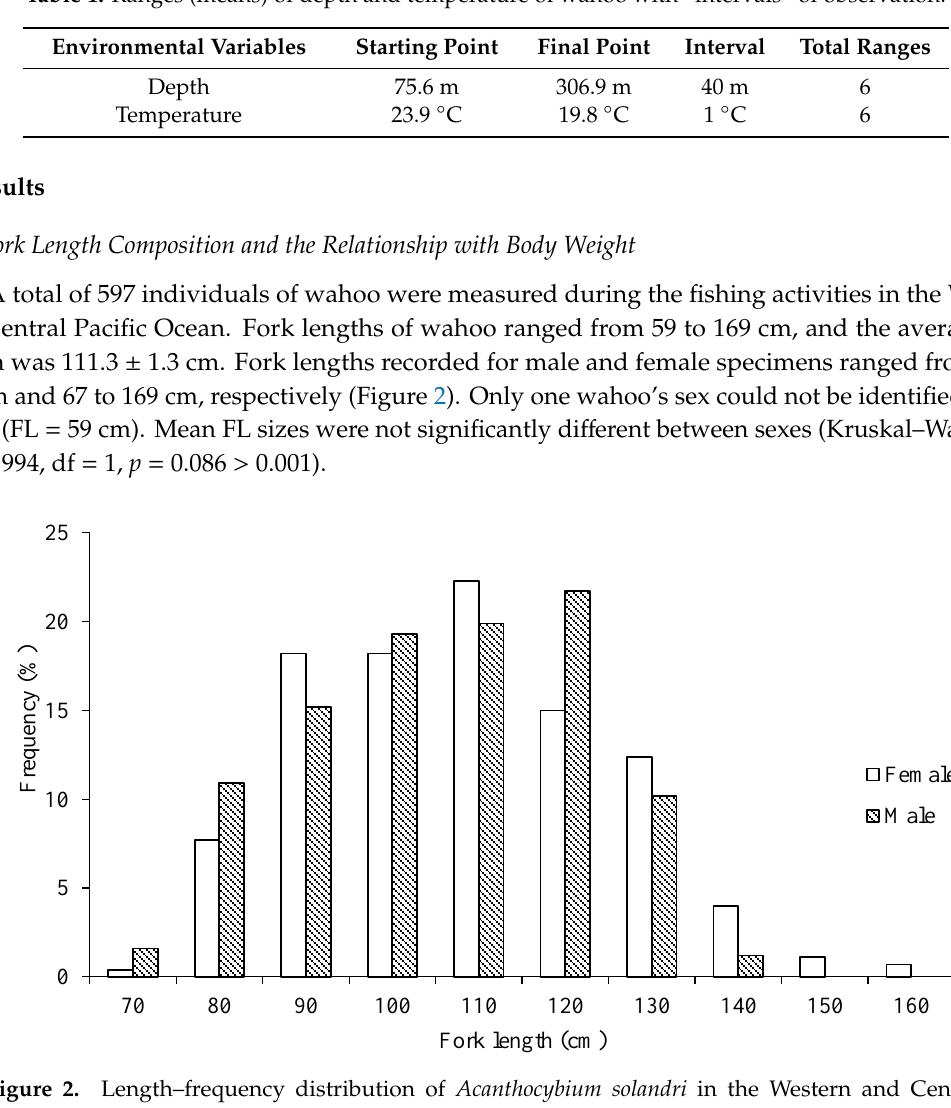
Figure 2. Length–frequency distribution of Acanthocybium solandri in the Western and Central Pacific Ocean.